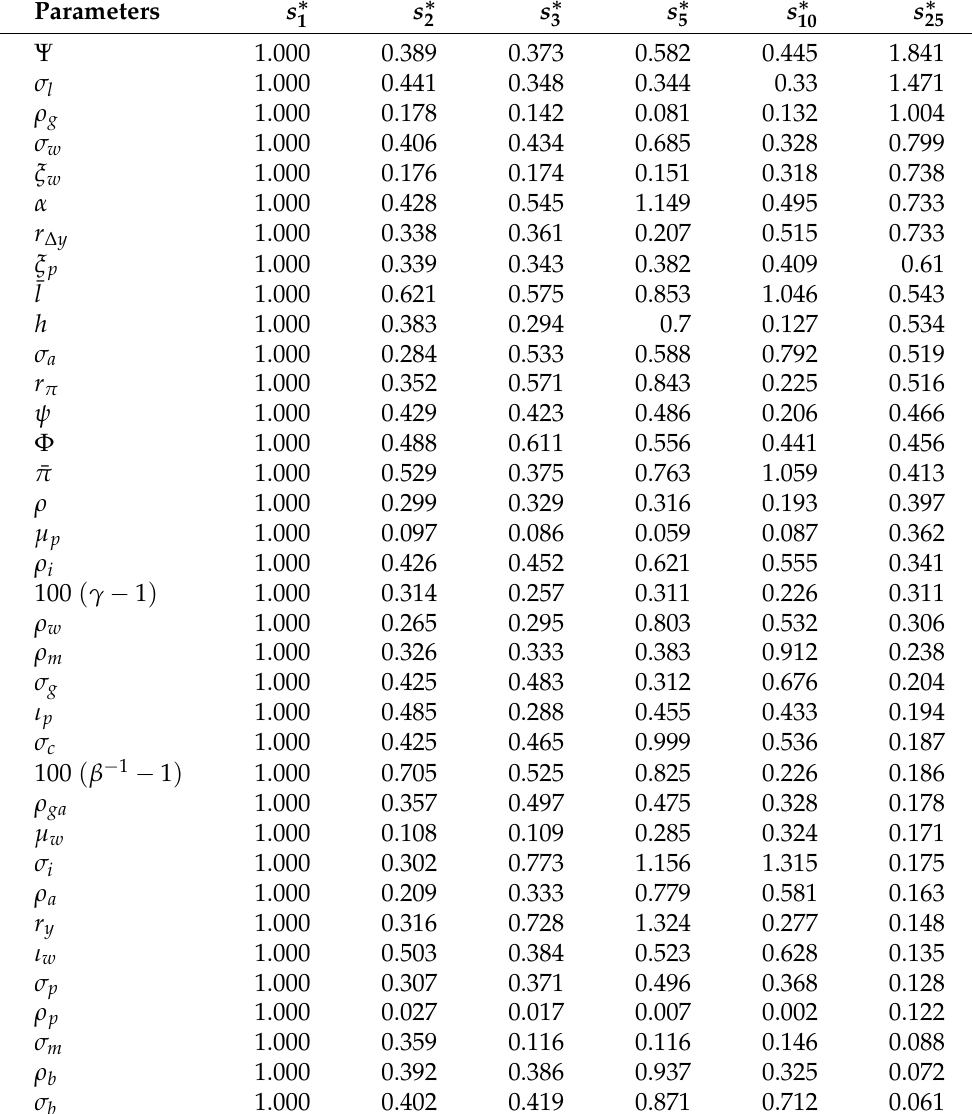
Table 2. Normalized data cloning posterior standard